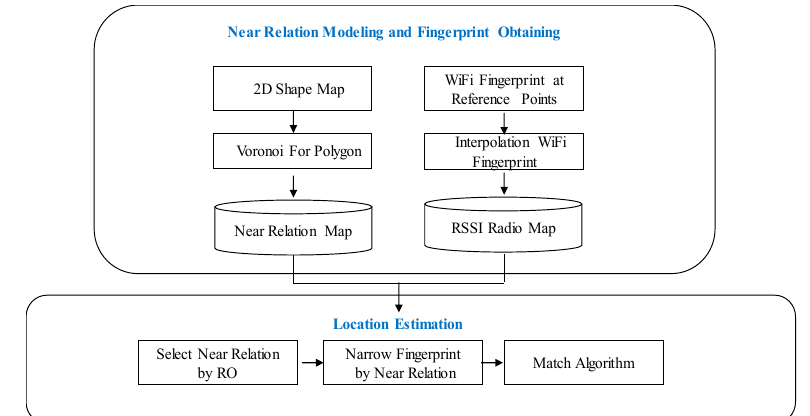
Figure 1. System overview.